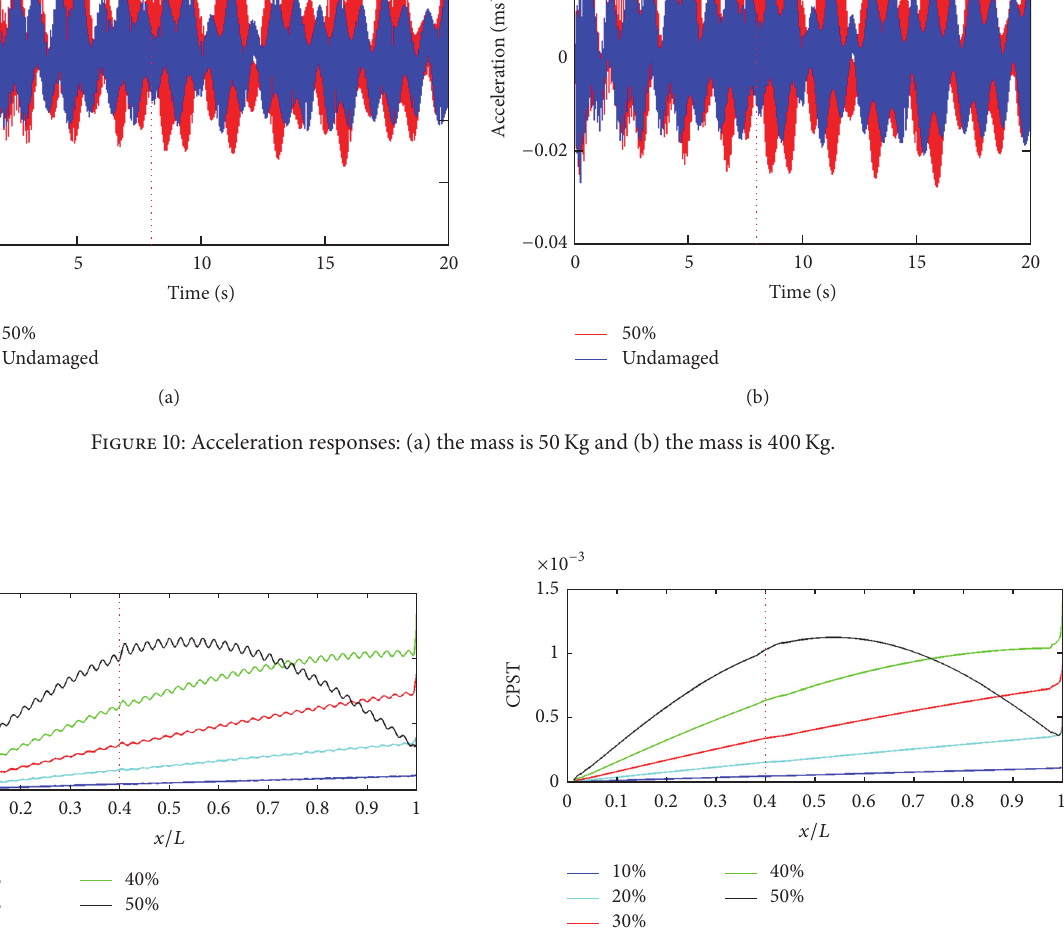
Figure 12: Filtered CPST of different damage levels using accelera- tion responses with the mass which is 50